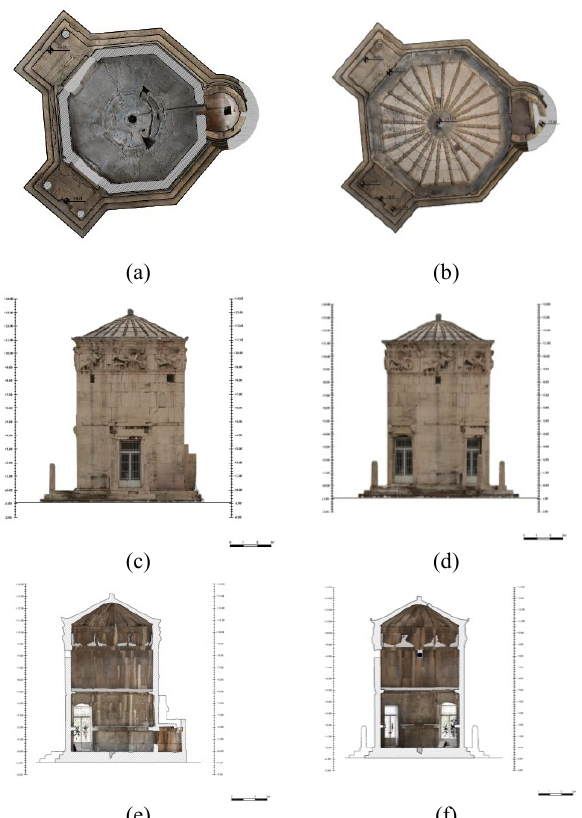
Figure 11: Samples of the final drawings. A horizontal